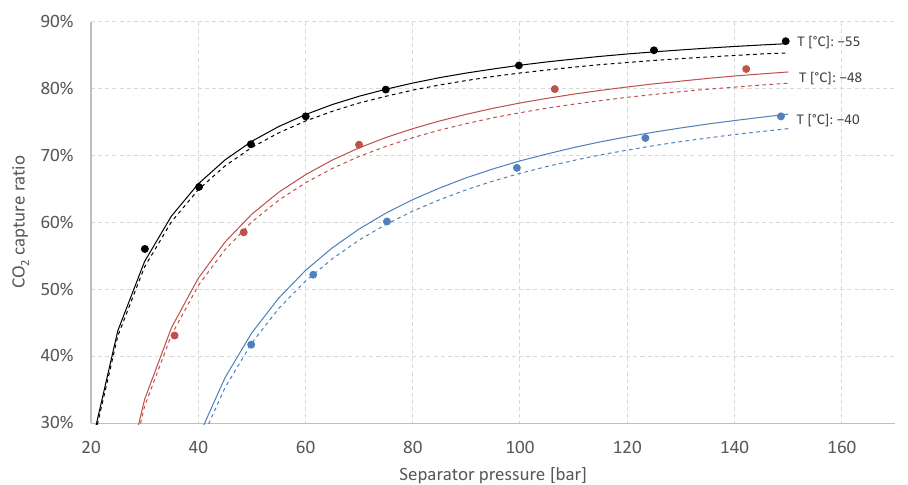
Figure 5. Estimated CCR for binary and actual syngas mixtures with approximately 38 mol% CO 2 .